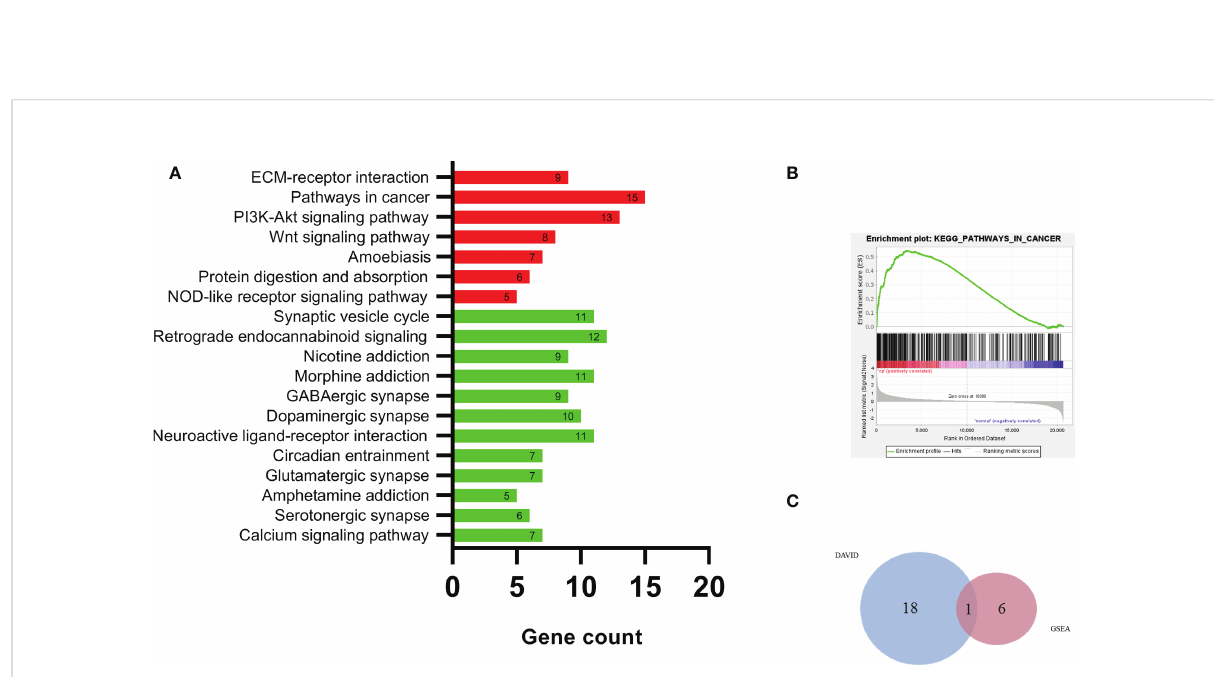
FIGURE 4 The DEG KEGG pathway analysis by DAVID (A) , pathways in cancer (B) , and Venn plot of DAVID and GSEA (C) . KEGG, Kyoto Encyclopedia of Genes and Genomes; DAVID, Database for Annotation Visualization and Integrated Discovery; GSEA, Gene Set Enrichment